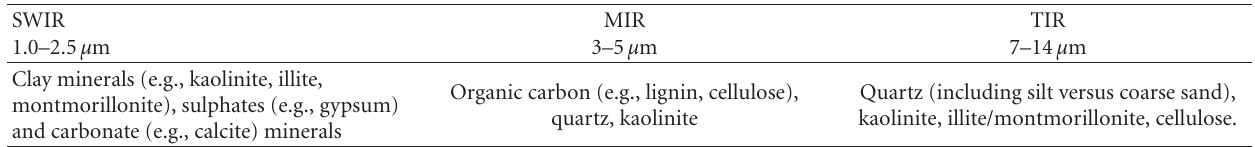
Organic carbon (e.g., lignin, cellulose), Quartz (including silt versus coarse sand), quartz, kaolinite kaolinite, illite/montmorillonite,